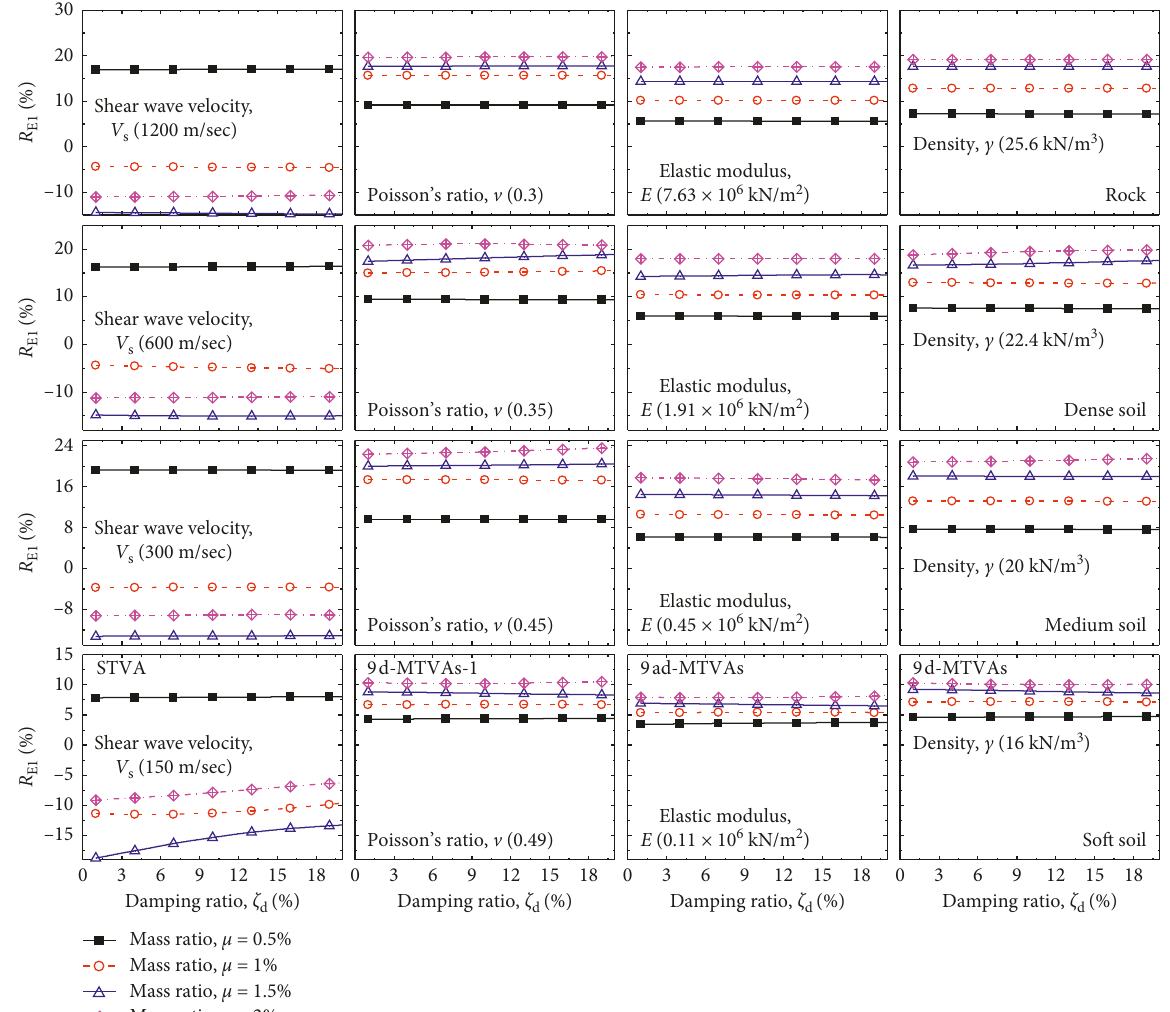
Figure 7: Variations of damping ratios ( ζ d ) for different mass ratios ( µ ) of the STVA, 9d-MTVAs-1, 9ad-MTVAs, and 9d-MTVAs installed on the chimney including SSI under Nahanni (1985) earthquake ground